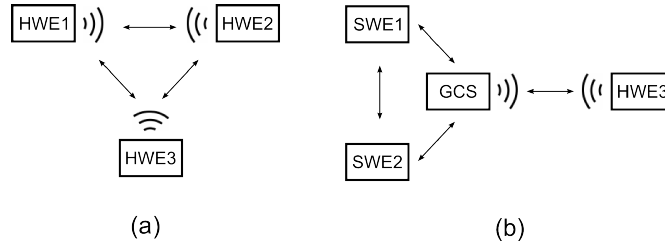
Figure 8. Two experimental scenarios—( a ) the three-HWE (HW) scenario with three hardware entities and ( b ) the MR scenario where one hardware and two simulated entities communicate via GCS